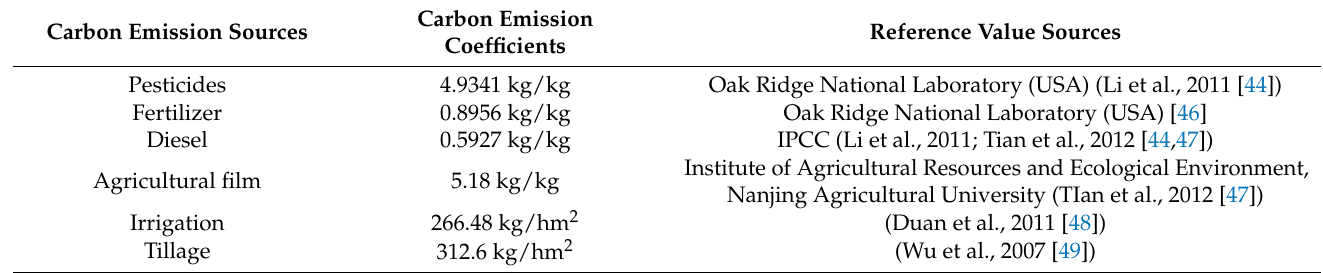
Table 1. Basis for determining agricultural carbon emission coefficients.